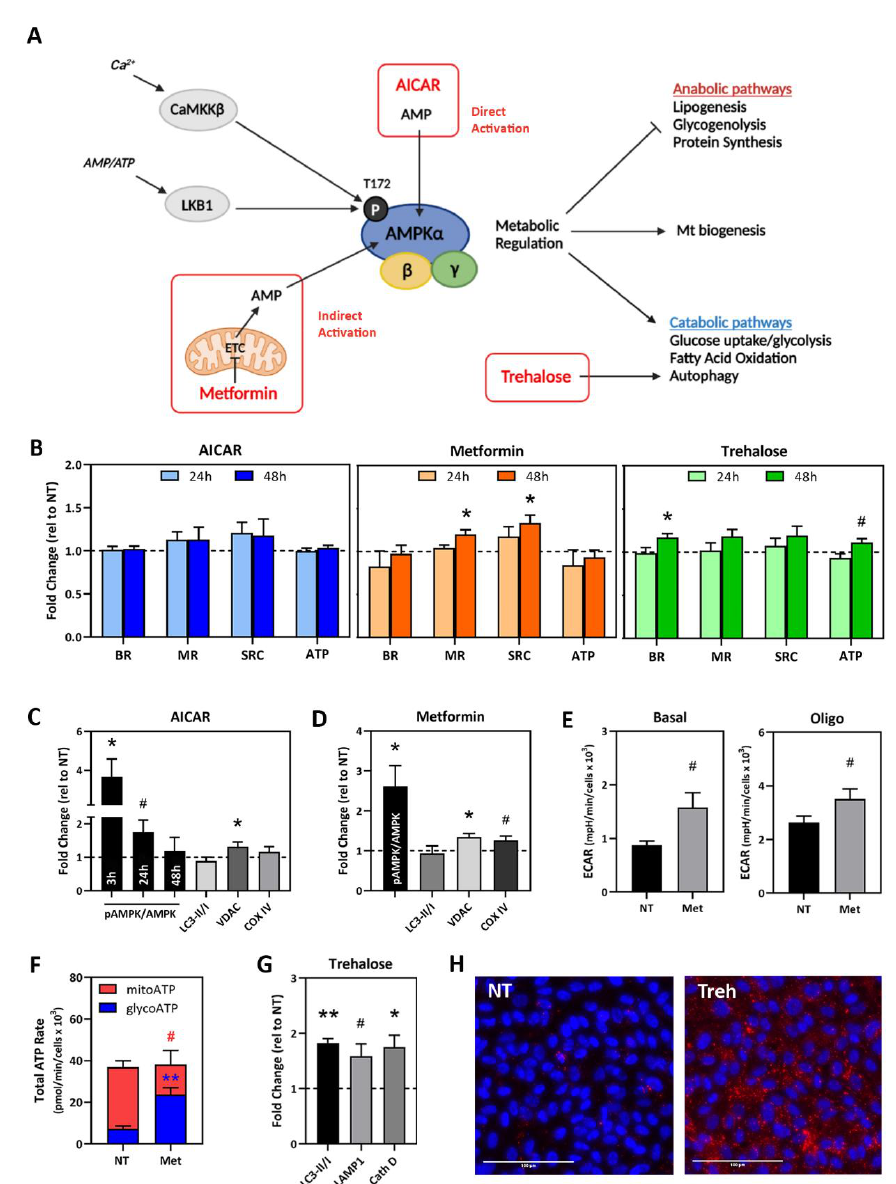
Figure 4. Characterization of drug treatment effect using AMD donor iPSC-RPE cells. ( A ) Schematic of AMPK activation and regulation of metabolism. ( B ) iPSC-RPE cells ( n = 4 donors) were treated with compounds (AICAR, Metformin, or trehalose) for 24 or 48 h. Mitochondrial function was evaluated using an XFe96 Extracellular Flux Analyzer. Calculated fold change values of mt function (compared to untreated controls) for the four lines are shown. BR = basal respiration; MR = maximal respiration; SRC = spare respiratory capacity; ATP = ATP-linked respiration. ( C , D ) Protein content in lysates from iPSC-RPE cells ( n = 4 donors) following incubation with 500 µM AICAR ( C ) or 2 mM Metformin ( D ). Calculated fold change values are shown (no treatment = 1, dashed line). ( E ) ECAR was measured during CMST assays ( n = 4 donors). ( F ) ATP Rate Assay was performed on iPSC-RPE ( n = 4) after Metformin treatment for 48 h. ( G ) iPSC-RPE ( n = 4 donors) were treated with 100 mM trehalose for 48 h. Content of autophagy-related proteins was determined in treated cells relative to untreated cells (dashed line). LC3-II/I, Lysosomal-Associated Membrane protein 1 (LAMP1), Cathepsin D (Cath D). ( H ) Maximal projection of z-stack images of LysoTracker™ staining (red) labeling lysosomes in untreated (NT) and trehalose treated (Treh) iPSC-RPE cells. Nuclei are stained with DAPI (blue). Scale bar = 100 µ m. Data in ( A – G ) are mean ± SEM. One-sample t -tests were used to compare treatment to no treatment in ( C , D , G ). Unpaired t -tests were used to compare treatment to NT in ( A , E , F ). ** p < 0.01, * p < 0.01, # p <